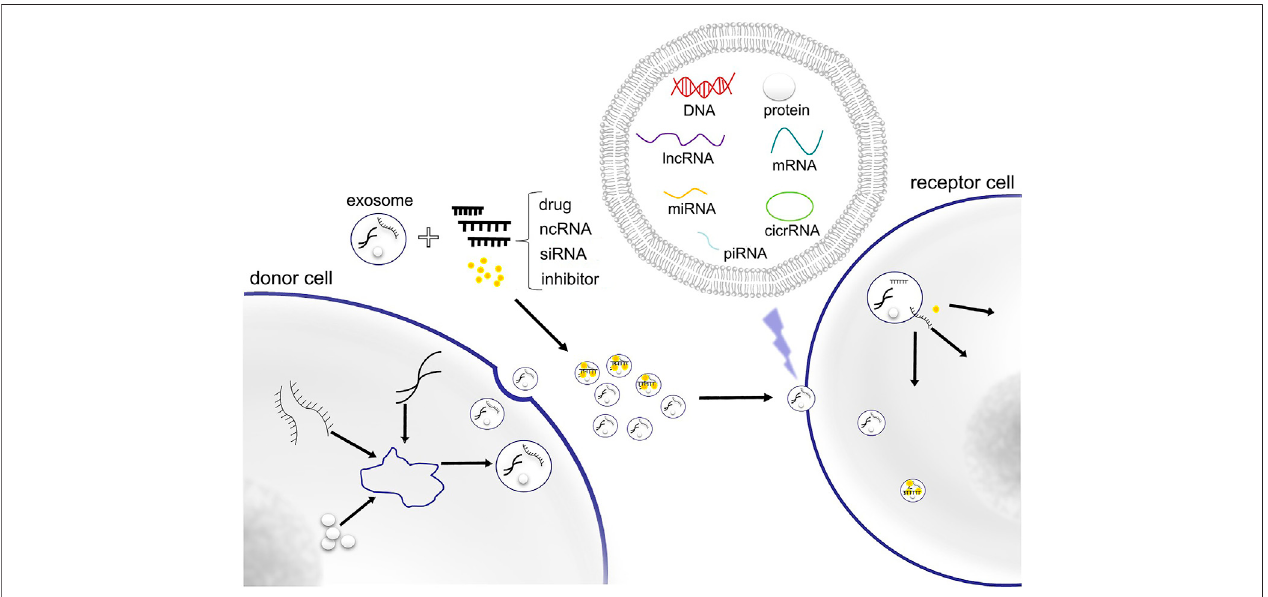
FIGURE1| ExosomecontainsDNA,RNA,proteinandothersubstancesforcellularcomponentcommunication.Exosomescanalsobeusedasdeliveryvectorsof drugs, ncRNA, siRNA and inhibitor.